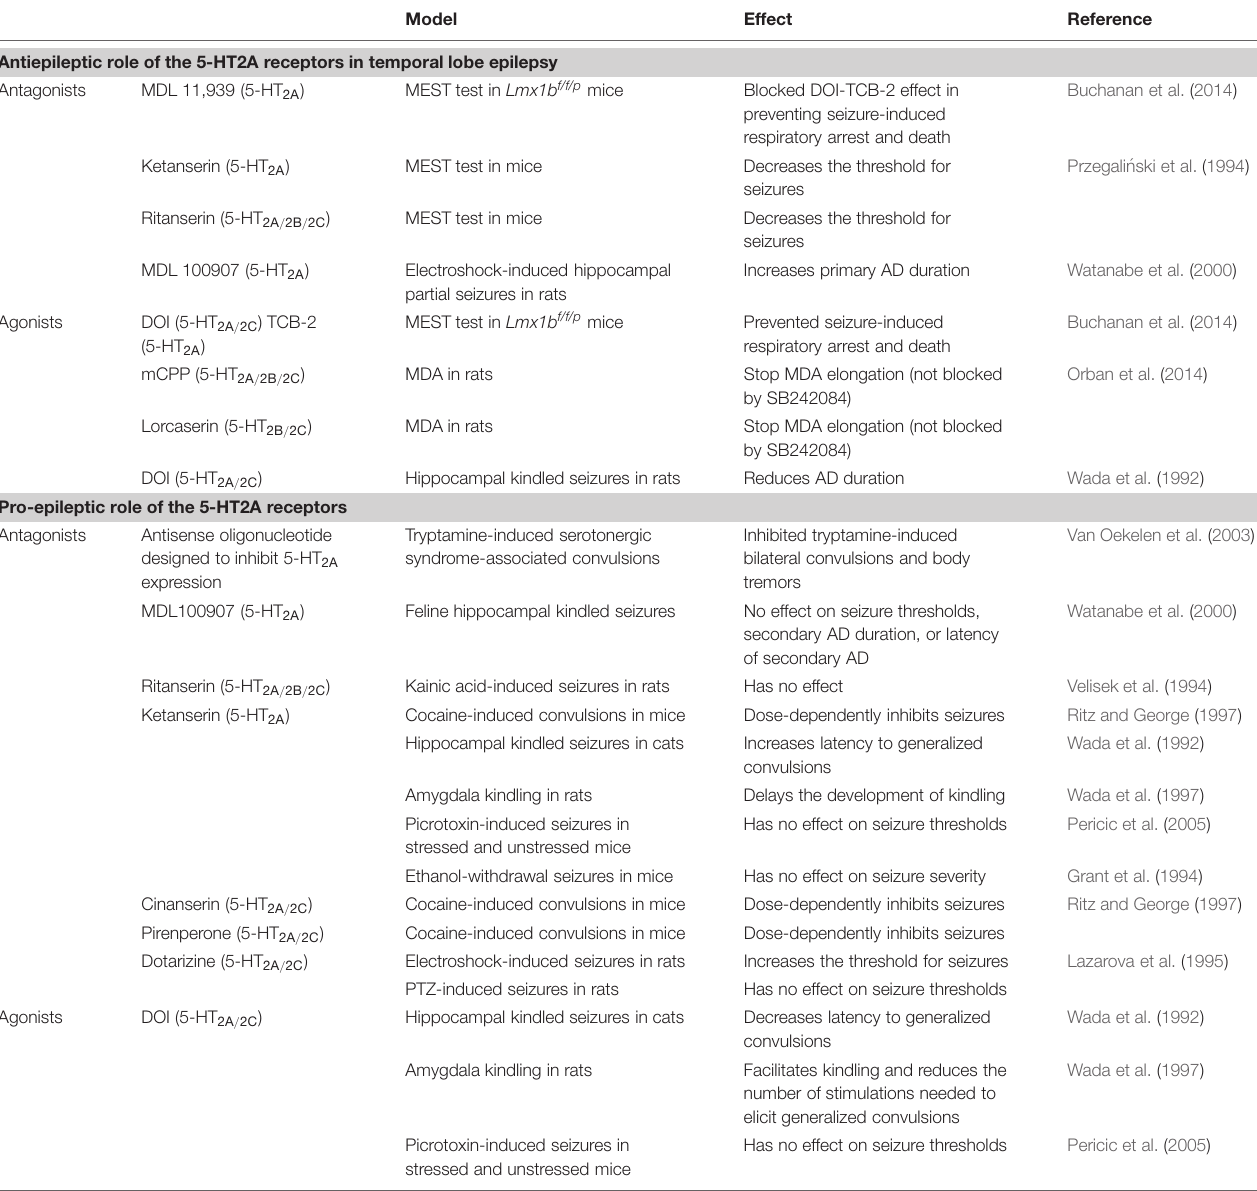
TABLE 1 | Role of the 5-HT2A receptors in temporal lobe